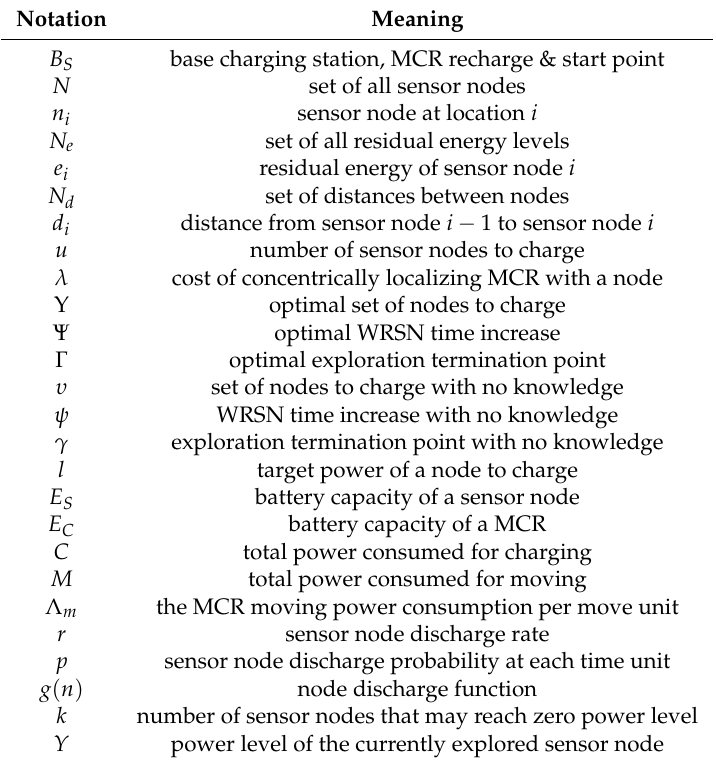
Table 1. Notations used in problem